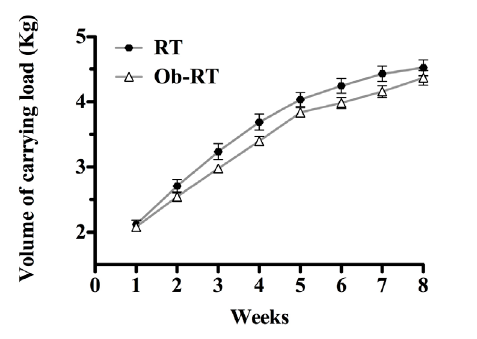
Figure 3 - The volume of the carrying load (Kg). RT, resistance training group; and Ob-RT, obese trained